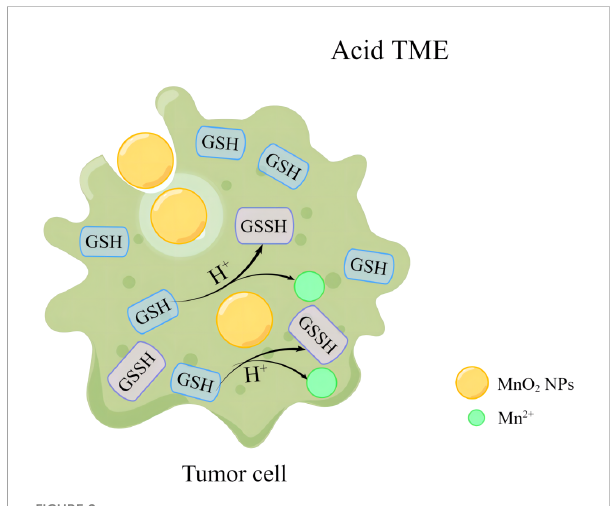
FIGURE 2 MnO 2 NPs remodel tumor microenvironment by reacting with GSH to release Mn 2+